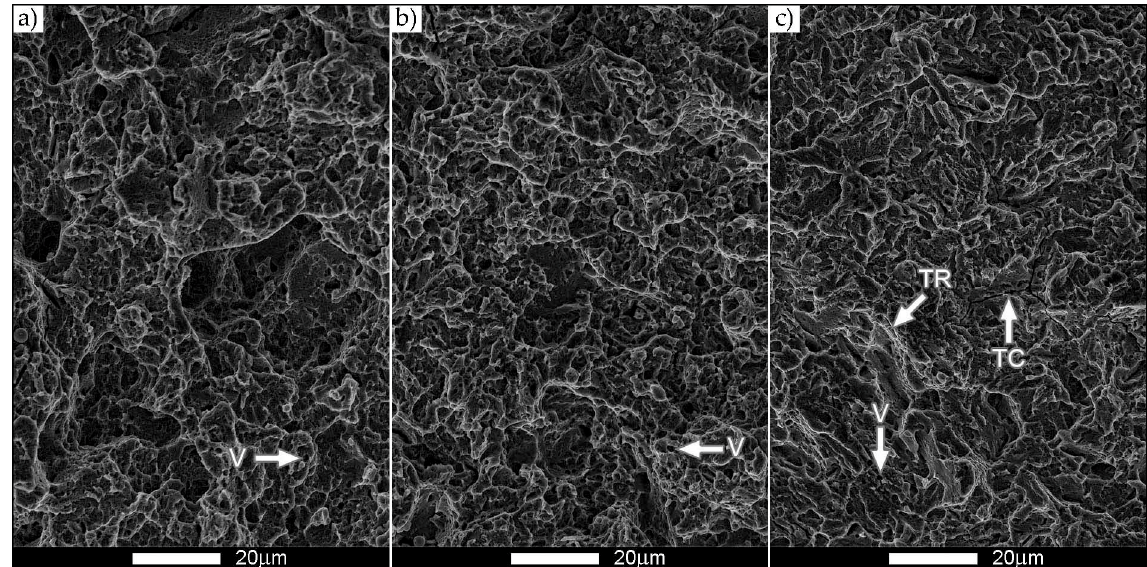
Figure 11. Images of the Hardox Extreme steel fracture surface in delivery state shown in Figure 9: longitudinal orientation (+20 °C). ( a ) The area marked with the A1 frame. ( b ) The area marked with the B1 frame. ( c ) The area marked with the C1 frame. TR—tear ridges, V—microvoids, I—inclusions, voids left after debonded inclusions, TC—transversal cracks. SEM, non-etched state.